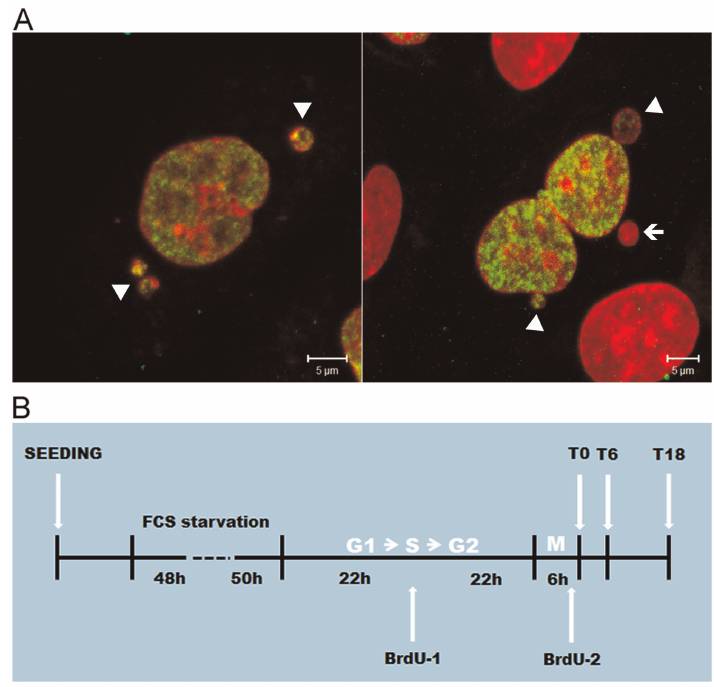
Figure 4. BrdU incorporation as a tool to analyze the micronucleus origin in synchronized A549 cells. A , Illustrative images of BrdU incorporation in A549 cells. Micronuclei